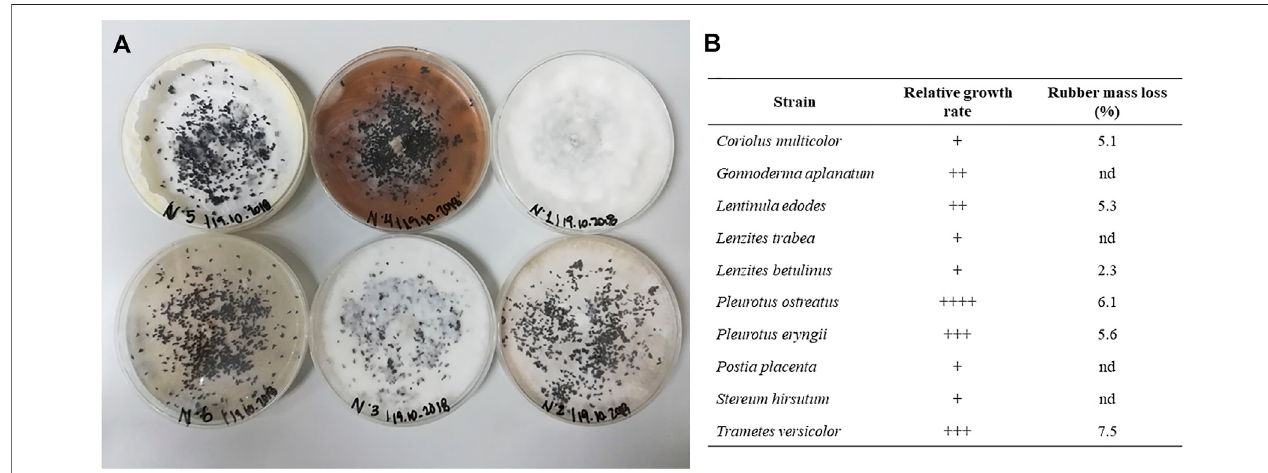
FIGURE1|(A) Growthoffungalspeciesinthepresenceofvulcanisedrubberparticles. (B) Relativegrowthrateandrubbermassreductionofthe10fungalspecies after incubation.